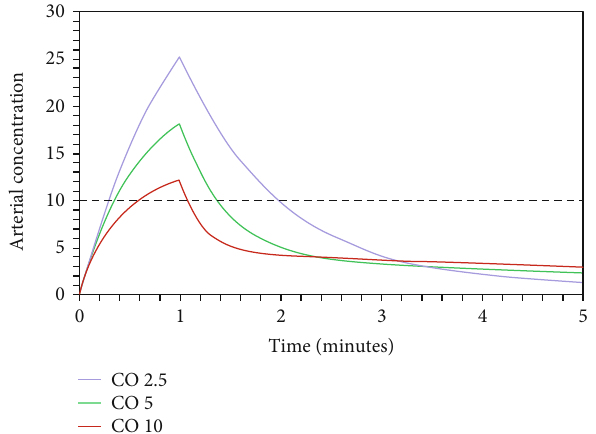
Figure 2: Sodium thiopental anesthetic e ff ects related to the condition of arterial concentration and neurological activity (source: